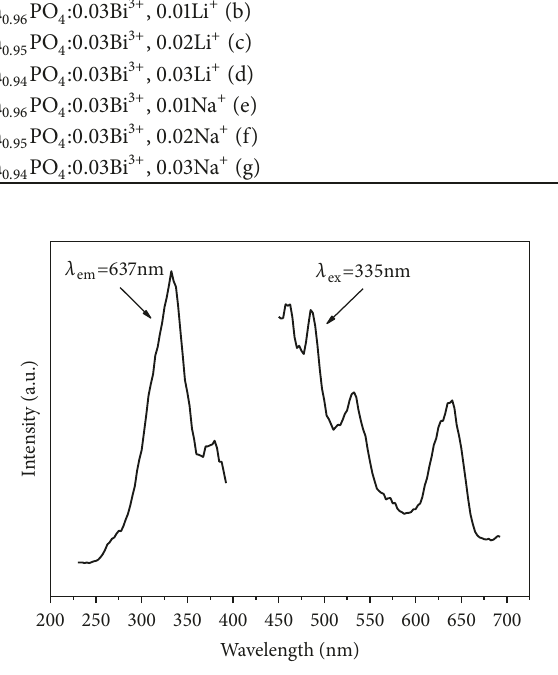
Figure 4: PL and PLE spectra of La 0.97 PO 4 :Bi 3+ 0.03